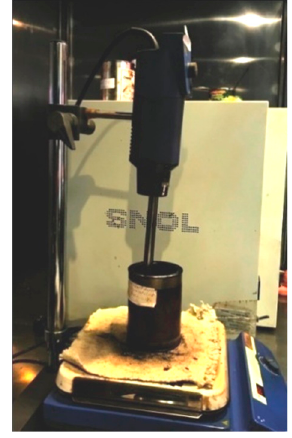
Figure 2. Laboratory mixing device.